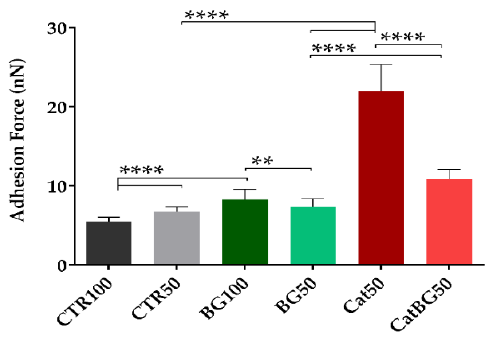
Figure 12. Adhesive force of the LbL films determined by AFM in dry state. Significant differences were found for p < 0.01 (**) and p < 0.0001 (****).